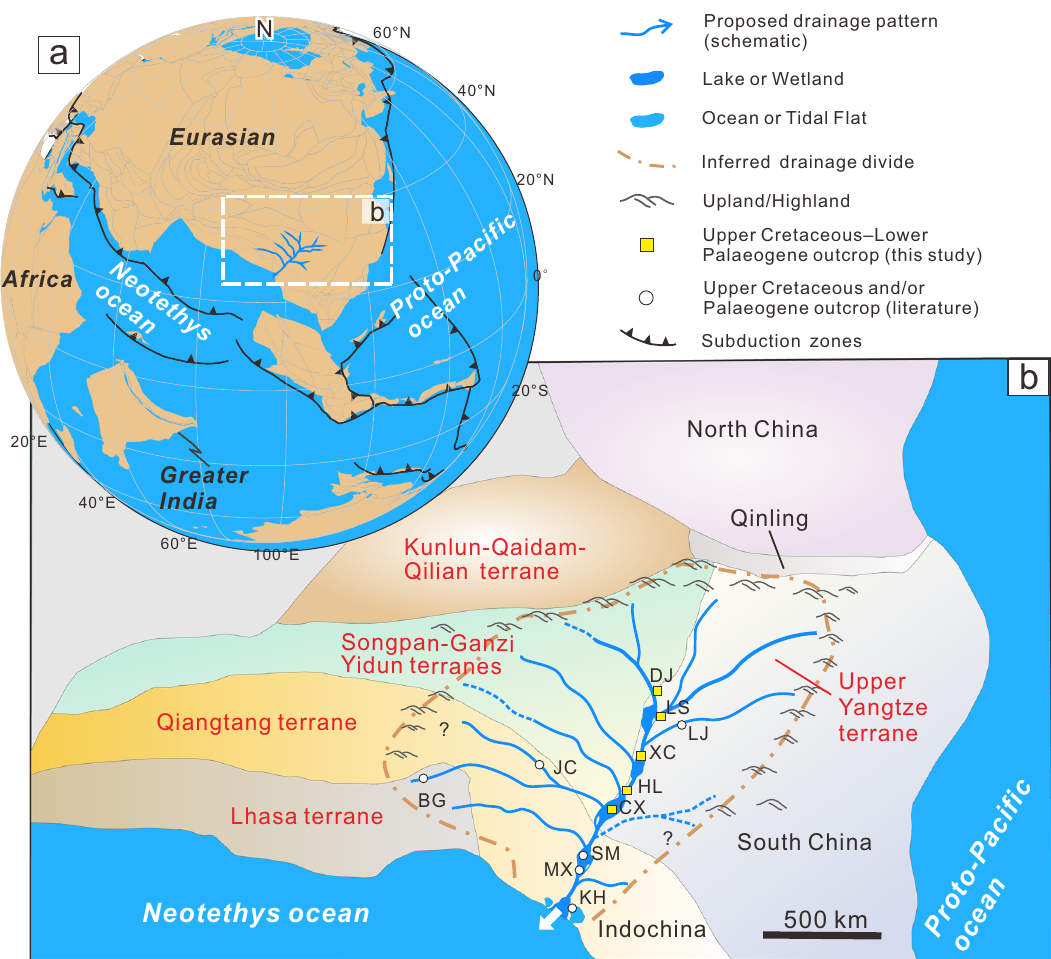
Fig. 4 Schematic reconstruction of paleogeography before the India-Asia collision. a Plate reconstruction of East Asia during the latest Cretaceous (generated from Müller et al. 68 ). b Reconstruction of the late Cretaceous – early Palaeogene drainage system in eastern Tibet based on this study. KH Khorat Basin, MX Muang Xai Basin, LJ Liujia Section, JC Jianchuan Basin, BG Bangoin. Other abbreviations as in Fig.